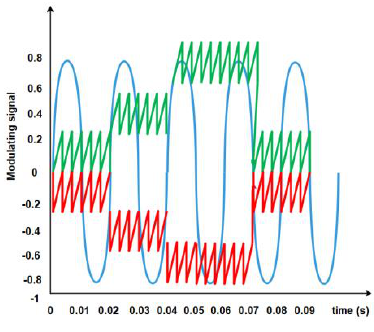
Figure 39. Modified PWM signal.